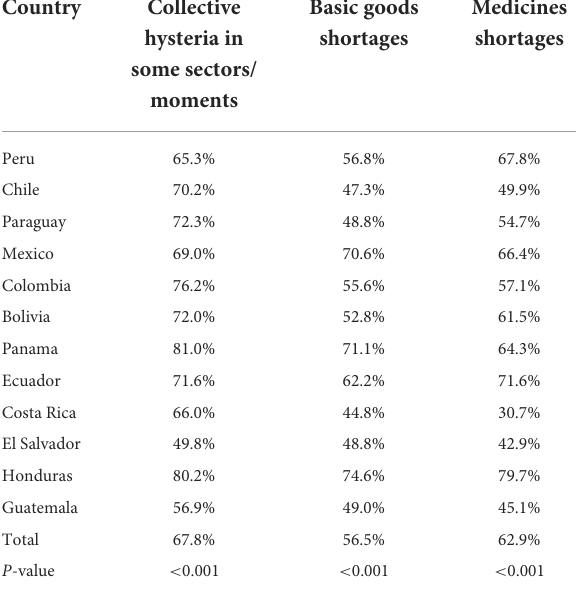
TABLE 1 Perception of collective hysteria and shortages in 12 Latin American countries during the first wave of the COVID-19 pandemic.